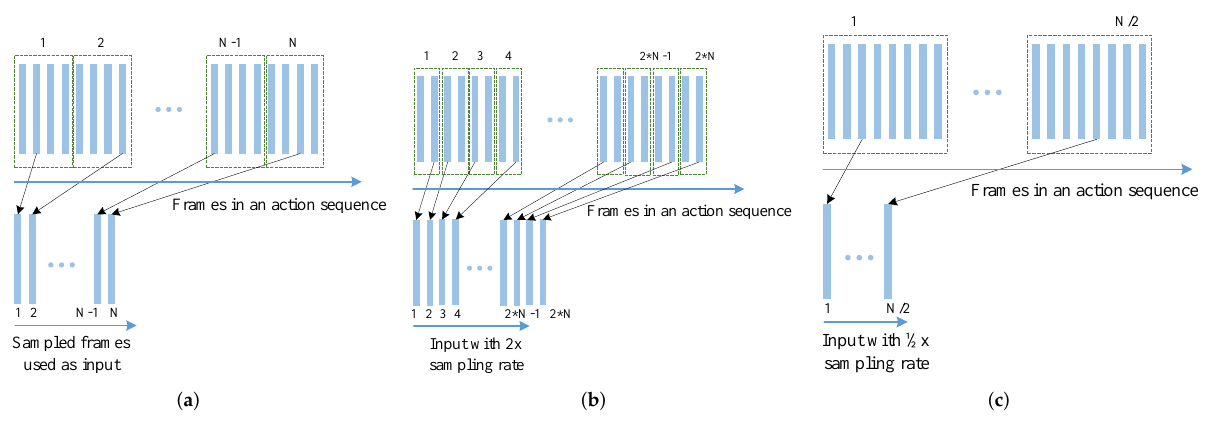
Figure 2. Illustration of the sampling strategy with different sampling rates. ( a ) Conventional sampling with a sampling rate to extract N frames as the input. ( b ) Sampling with 2 × sampling rate to extract 2*N frames as the input. ( c ) Sampling with 1/2 × sampling rate to extract N/2 frames as the input.